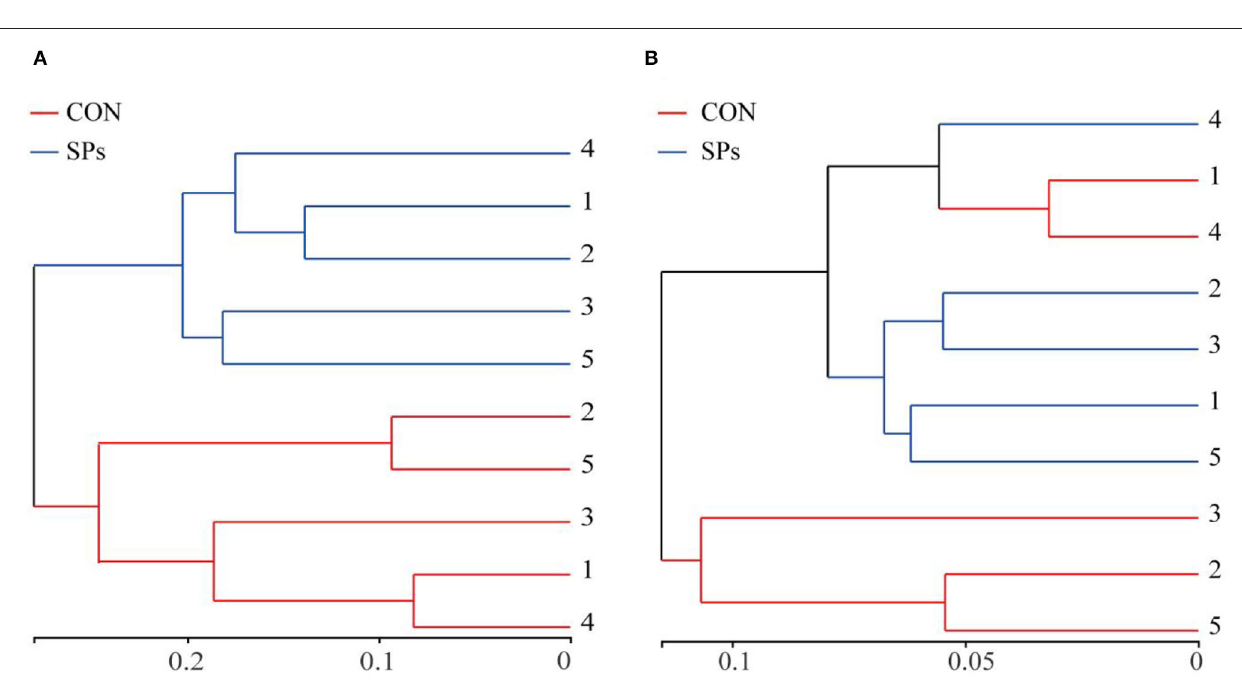
FIGURE 3 | Hierarchical clustering according to OTU levels. (A) Hierarchical clustering of ruminal bacteria based on Bray – Curtis distance. (B) Hierarchical clustering of ruminal bacteria based on Binary Jaccard distance. CON, the control group with no soybean peptide supplementation; SPs, the group with 50 g/head/day of soybean peptide